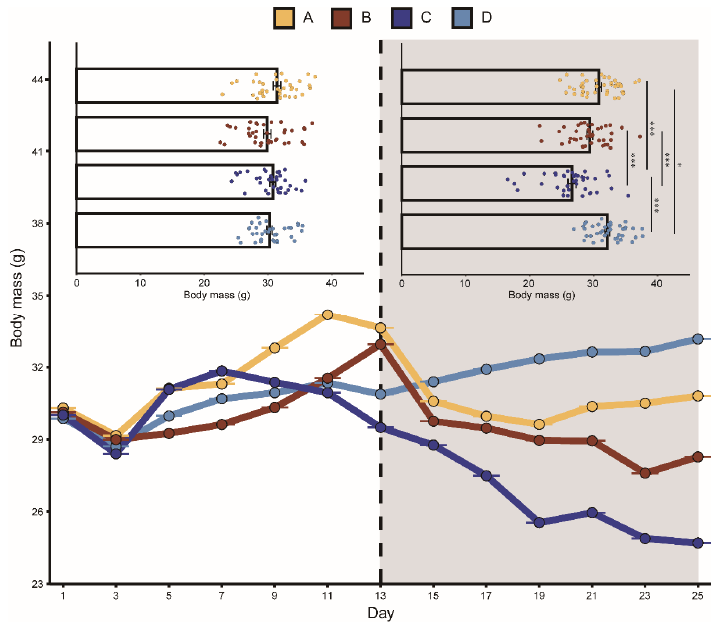
Figure 3. Change in body mass of bats in different groups. The playback period is represented by the dark grey box. A represents the noisy-calls playback group, B represents the tonal-calls playback group, C represents the white-noise playback group, and D represents the control group. The bar chart shows the results of the Kruskal–Wallis test, and the data are presented as mean ± standard error of the mean. * means p <0.05, and *** means p < 0.001.